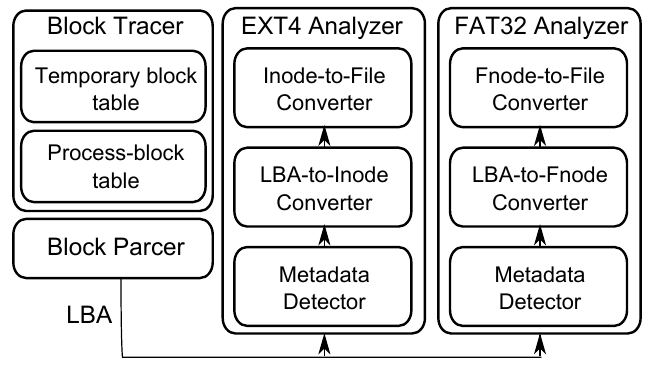
Figure 4. Mobile storage